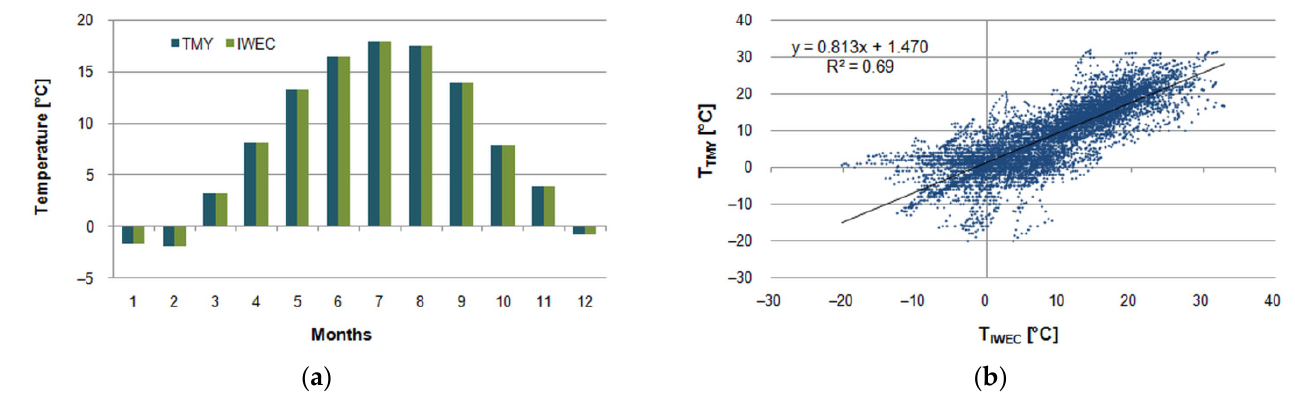
Figure 7. Air temperature in Kraków according to weather data from TMY and IWEC: ( a ) monthly; ( b ) hourly.